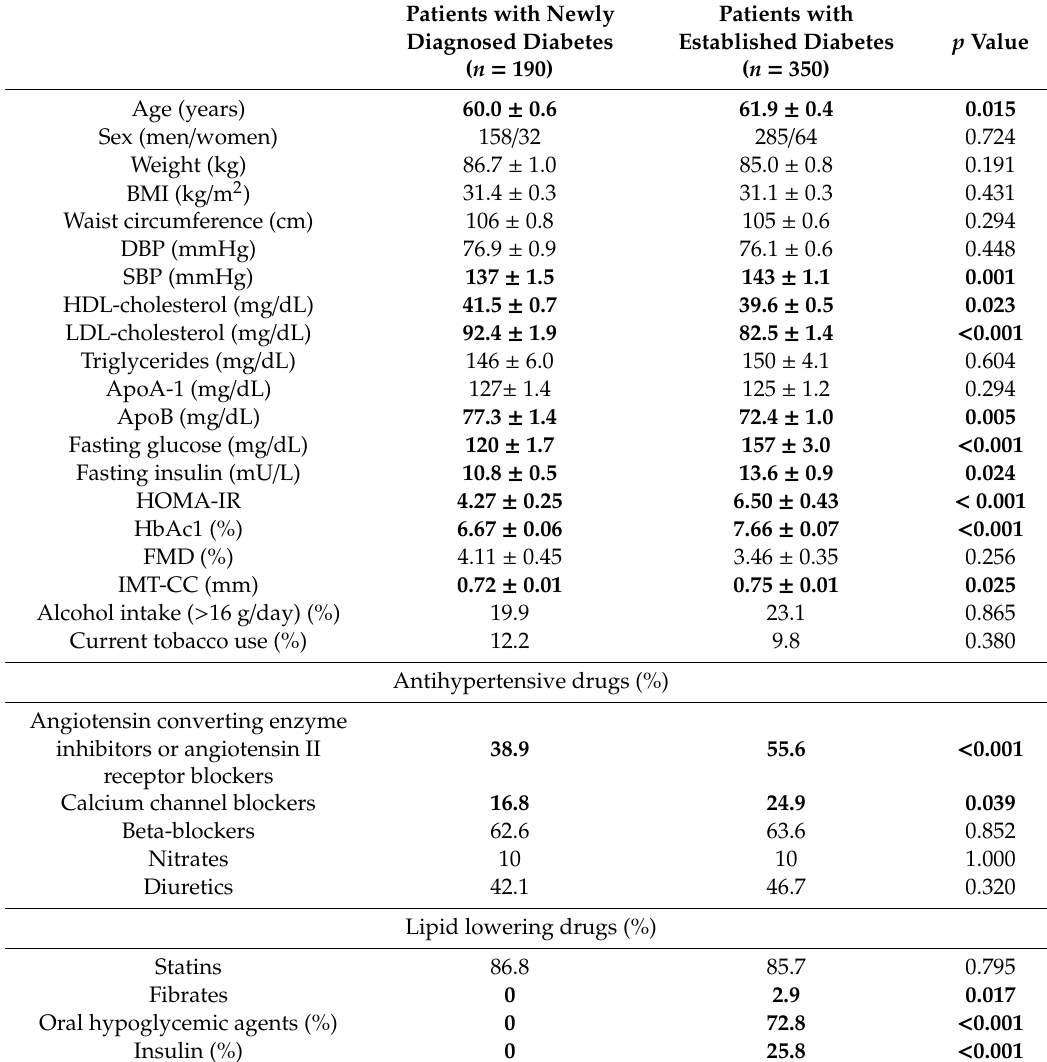
Table 1. Characteristics of the study groups 1